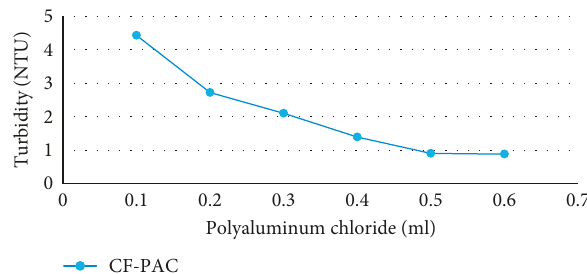
Figure 3: Turbidity of raw water of tap water treated with poly- aluminum chloride.